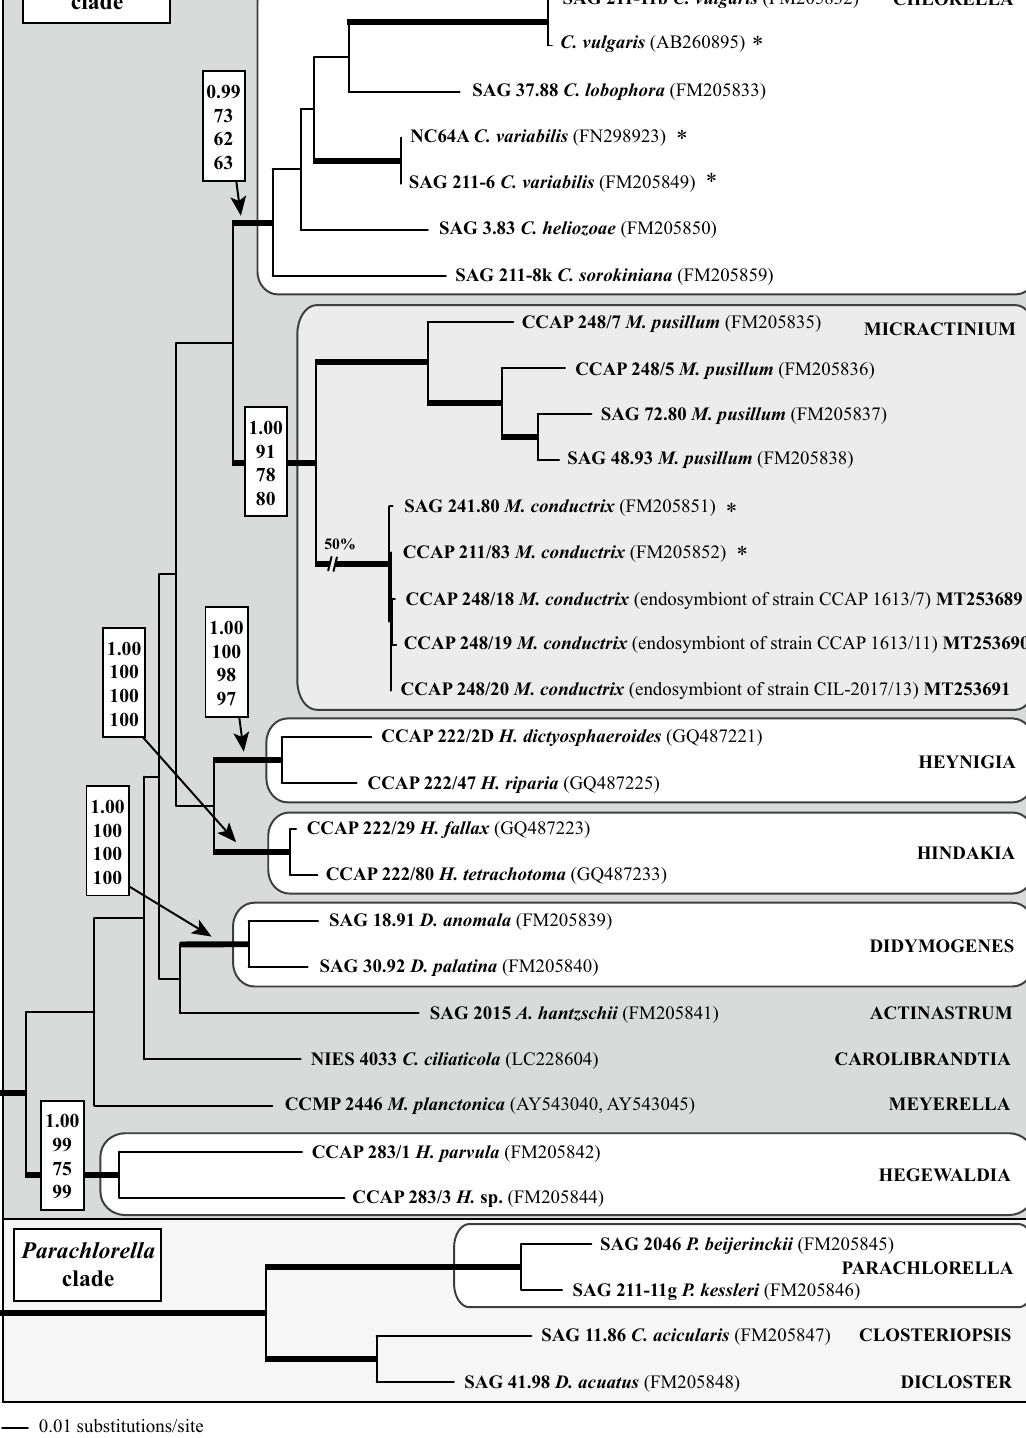
Figure 7. Molecular phylogeny of the Chlorellaceae based on SSU and ITS sequence comparisons. The phylogenetic trees shown were inferred using the maximum likelihood method based on the data sets (2604 aligned positions of 31 taxa) using PAUP 4.0a166. For the analyses, the best model was calculated by Modeltest 3.7. The setting of the best model was given as follows: GTR+I+G (base frequencies: A 0.2160, C 0.2732, G 0.2728, T 0.2380; rate matrix A–C 0.8499, A–G 1.2840, A–U 1.1061, C–G 0.6217, C–U 3.1850, G–U 1.0000) with the proportion of invariable sites (I = 0.6996) and gamma shape parameter (G = 0.5575). The branches in bold are highly supported in all analyses (Bayesian values > 0.95 calculated with MrBayes, 5 million generations; bootstrap values > 70%, calculated with PAUP, 1000 replicates using maximum likelihood, neighbour-joining, and maximum parsimony). The endosymbionts that were previously detected in Paramecium bursaria are marked with an